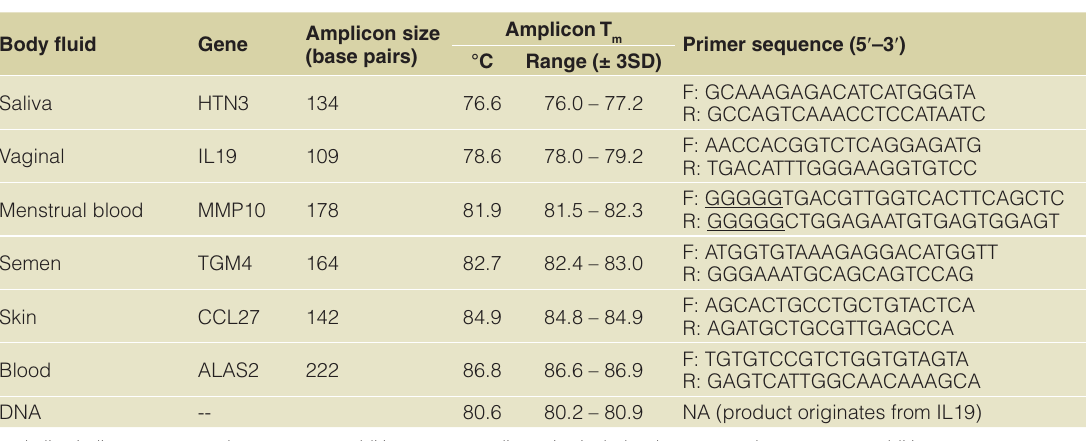
Table 3. Genes and amplicons used in the hexaplex body fluid HRM